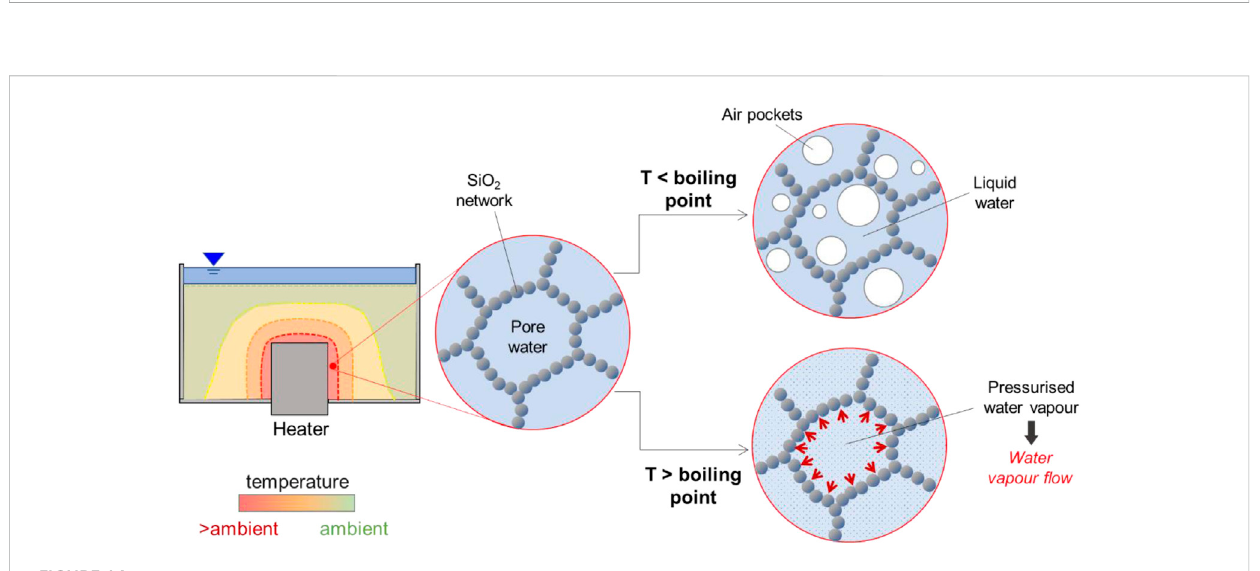
FIGURE 14 Temperature effects on the pore water contained within the silica